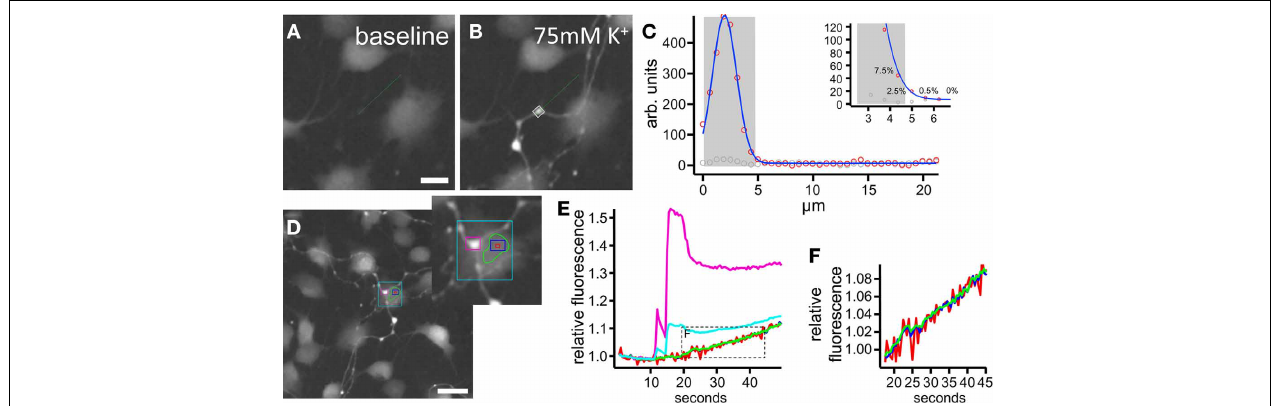
FIGURE 2 | Quantification of Fluo4 signals in regions of interest (ROI). (A – C) Example of a neuronal fiber and bouton at rest (A) and depolarized with 75mM K + (B) . In (C) the amplitude (at rest in gray, depolarized in red circles) along the line marked green in (A) and (B) is plotted. As seen, especially in the inset, the signal drops sharply outside the intuitively drawn ROI [gray shade bar in (C) and gray box in (B) ]: the last pixel included contains 7.5% of the signal’s maximal amplitude, while